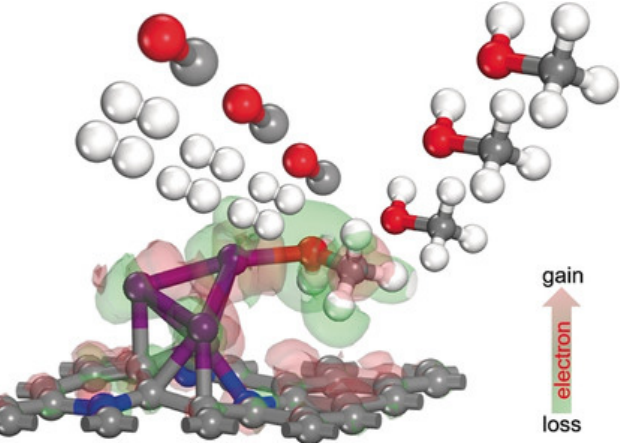
Figure 9. The dehydrogenation reaction of methanol by Ni/NCF catalysts. Reprinted with permission